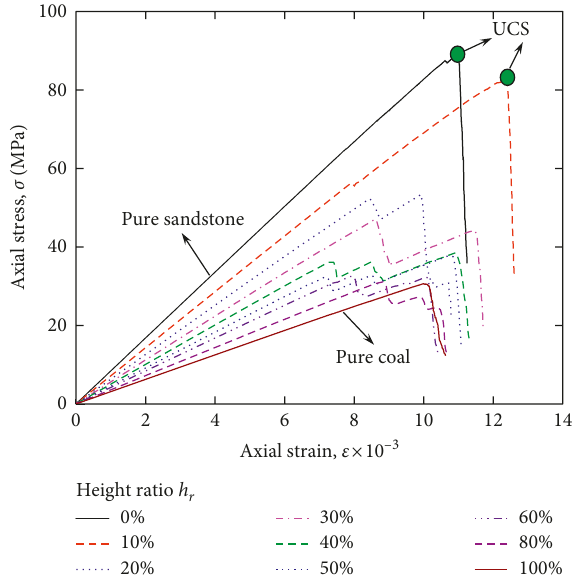
Figure 4: Stress-strain curves of the